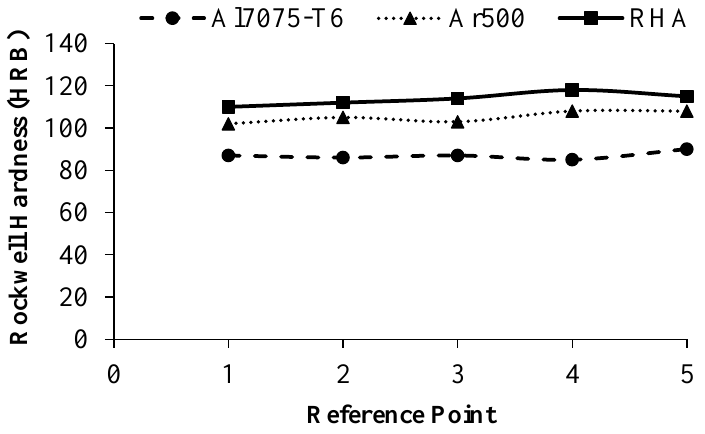
Figure 9. Rockwell hardness value at different punching point for each material. Table 4 . Summary of average hardness for each material.